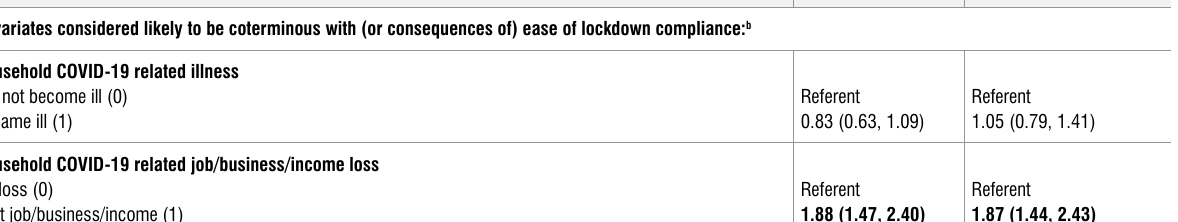
a Column 3.1: No adjustment for potential/preceding candidate confounding